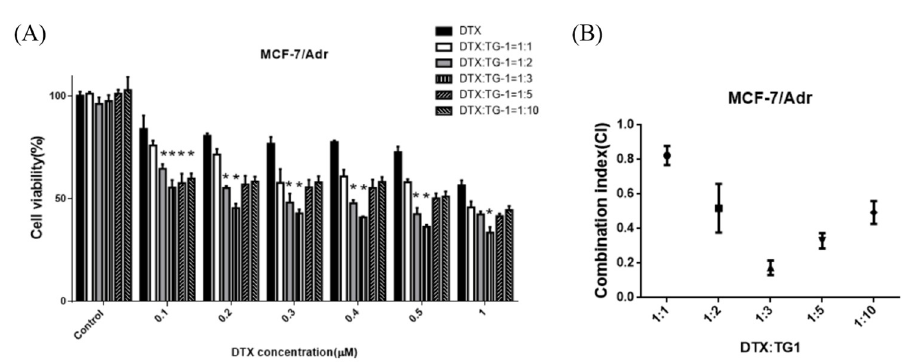
1:2, 1:3, 1:4 1:5 and 1:10. (B) Combination index of DTX and TG1 on different molar ratios for treating MCF-7/Adr cells. Data are shown as mean ± SD, n = 5. � p < 0.01, indicating significant differences between experimental and control groups.